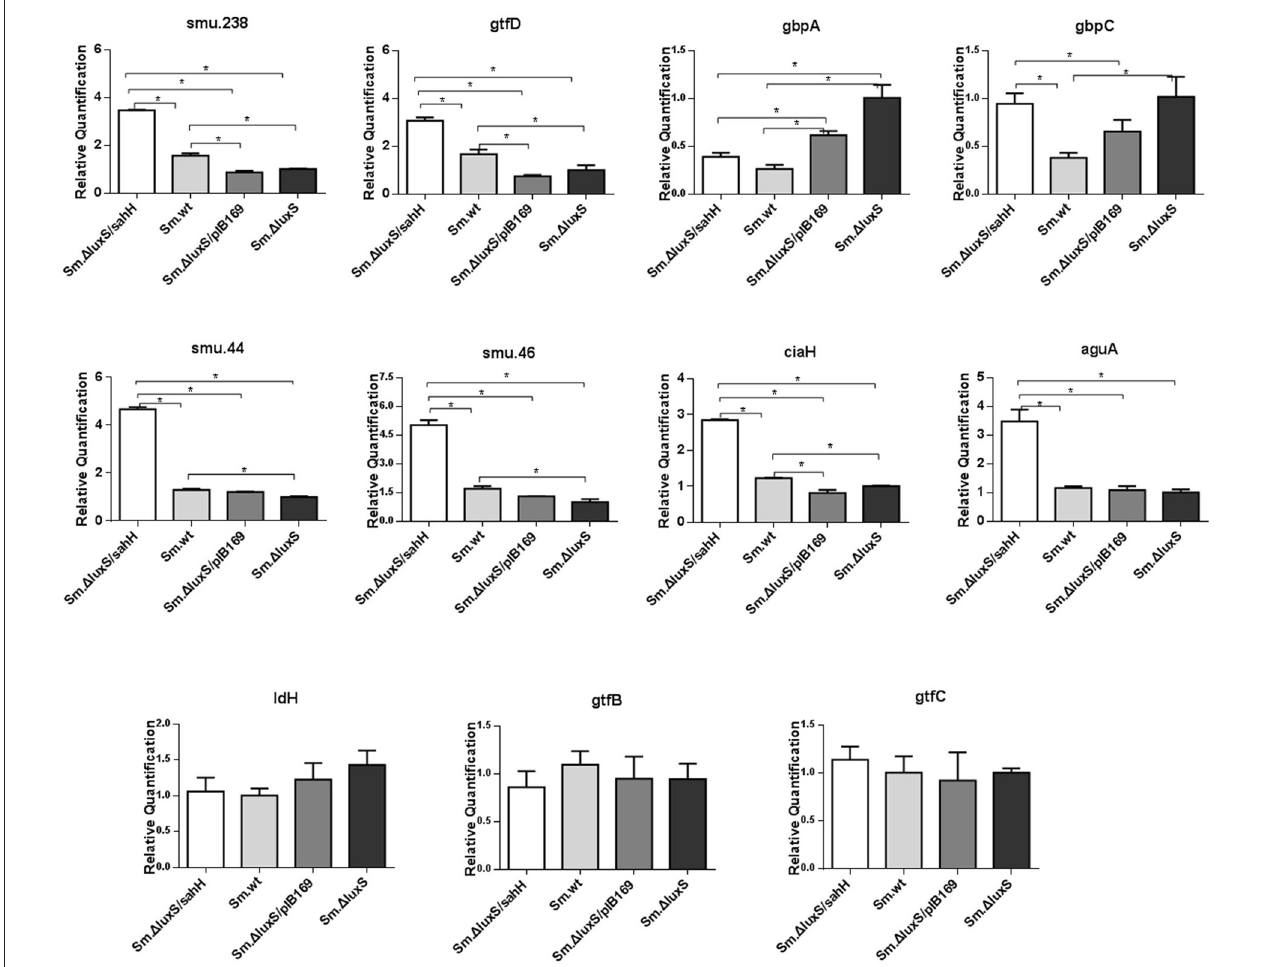
FIGURE 4 | Transcriptional comparison of studied genes with qRT-PCR. The 11 target genes were relevant to biofilm formation ( smu.238 , gtfD , gbpA , and gbpC ), aciduricity ( smu.44 , smu.46 , ciaH , and aguA ), acid generation ( ldH ), and synthesis of extracellular polymeric substances ( gtfB, gtfC ). RNAs were quantified with qRT-PCR and normalized to 16S rRNA transcripts. Results represent mean ± SD of relative quantification. *Significant differences at P <